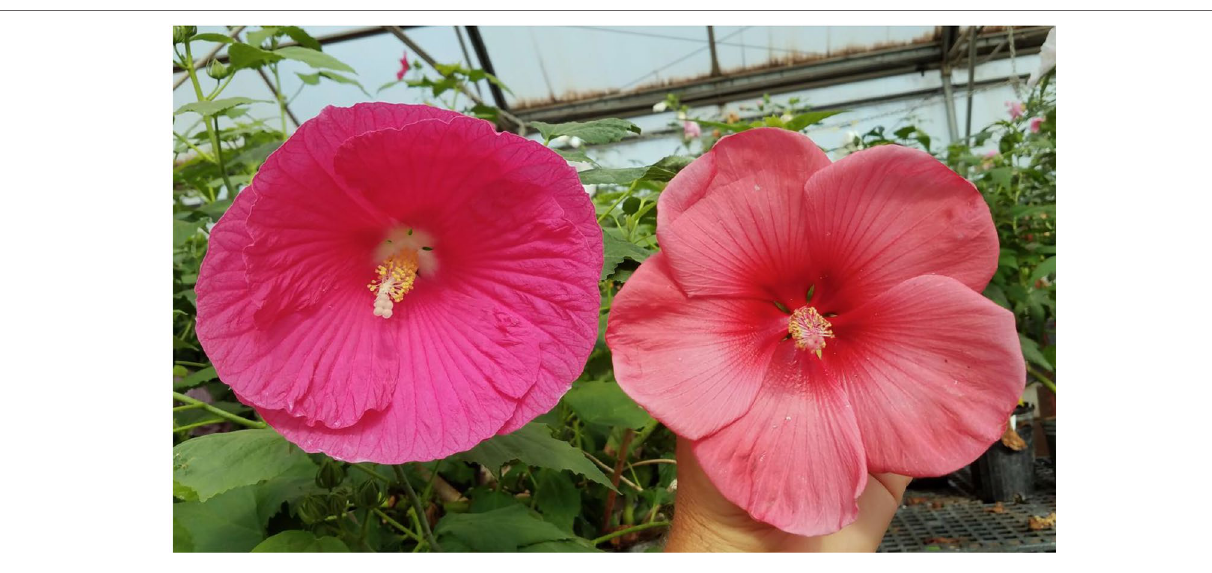
Frontiers in Plant Science |